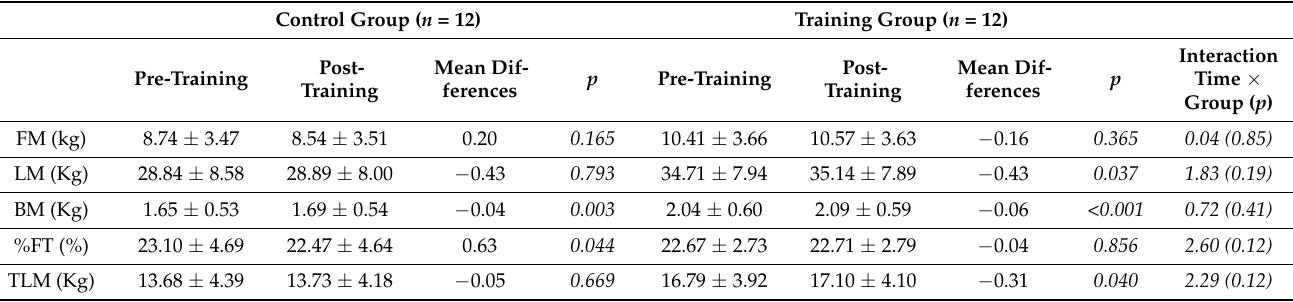
Table 3. Body composition and densitometry results (Mean ± SD).